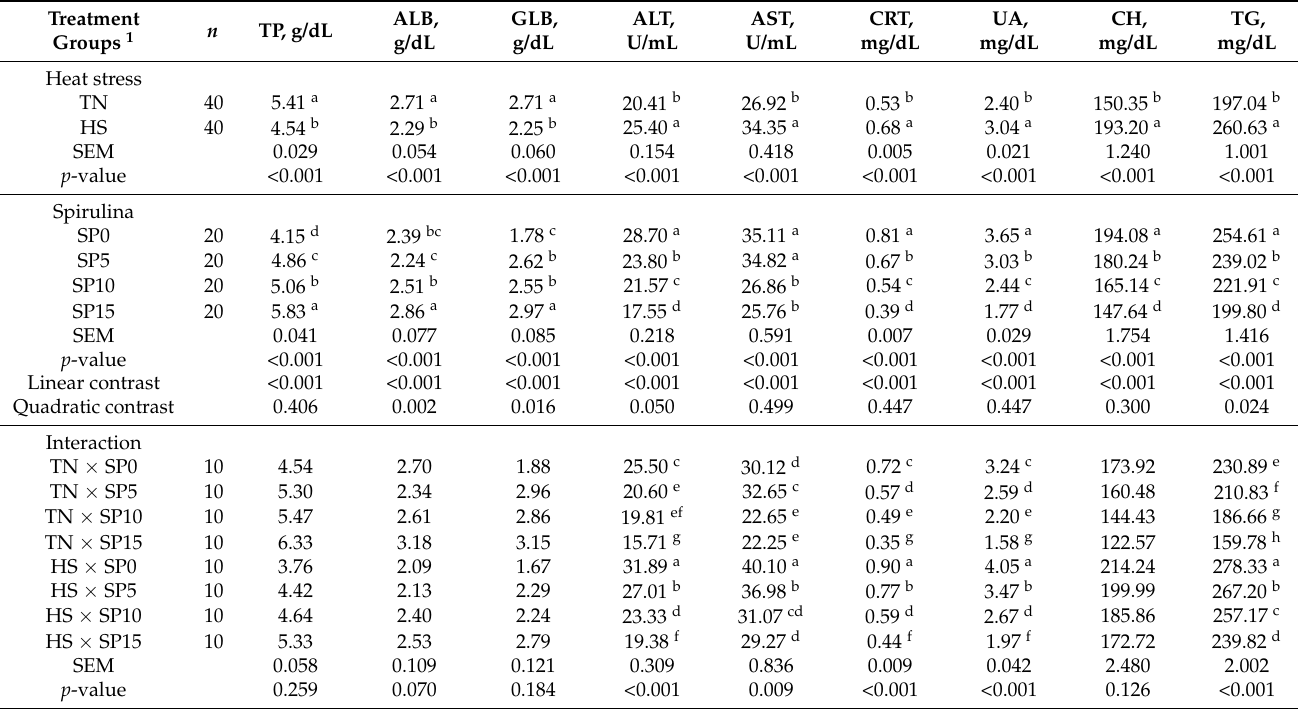
Table 5. Heat stress, spirulina, and their interaction effects on the physiological traits of Japanese quail chicks.